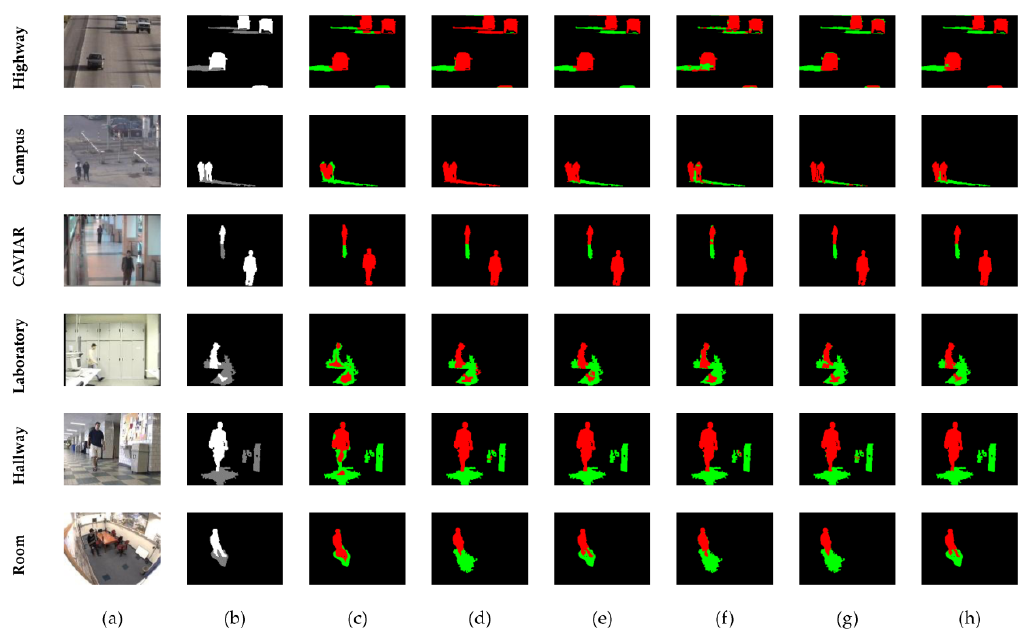
Figure 3. Visual shadow detection results of six scenes generated by the proposed method and comparative methods on the popular dataset. ( a ) input frames; ( b ) groundtruths; ( c ) results obtained by [21]; ( d ) results obtained by [20]; ( e ) results obtained by [31]; ( f ) results obtained by [26]; ( g ) results obtained by [22]; ( h ) results obtained by our